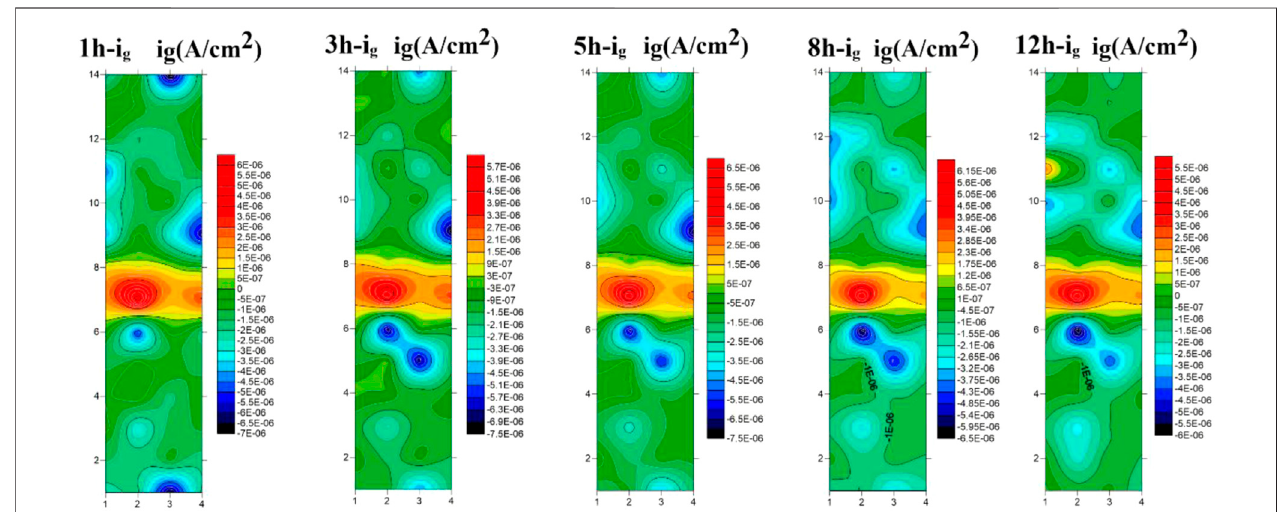
FIGURE 13 | WBE test results at 1.85 m/s fl ushing for 12 h after zonal coupling of welded joints.